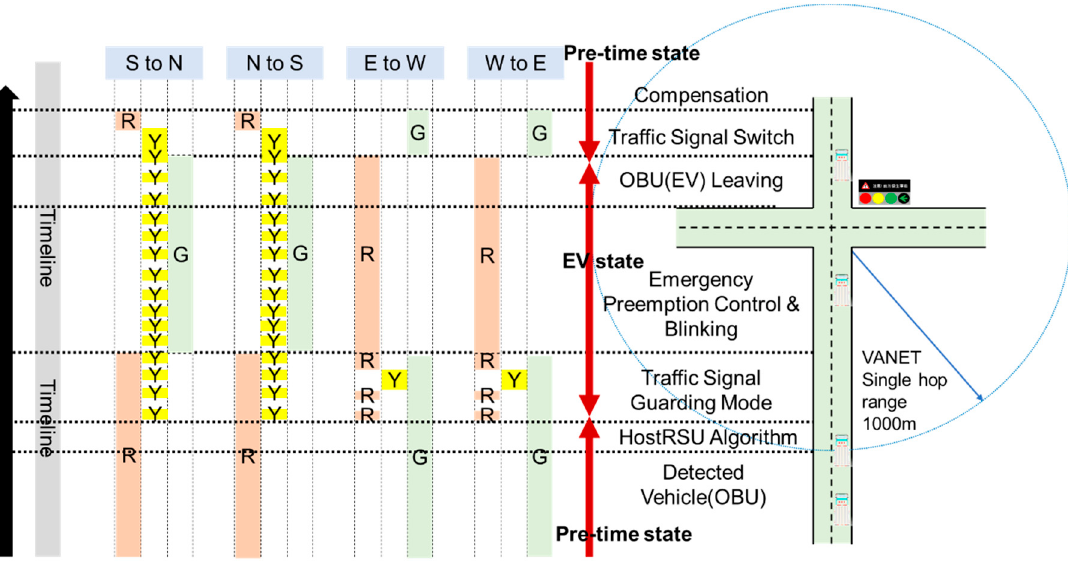
Figure 10. Traffic signal blinking mode (𝑅 (cid:3040)(cid:3042)(cid:3031)(cid:3032) ) . Figure 10. Tra ffi c signal blinking mode ( R mode ) .